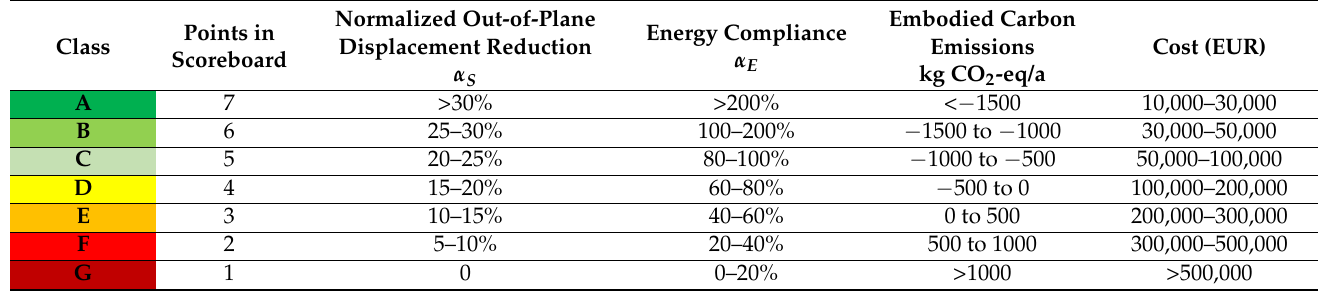
Table 5. Seismic and Energy Retrofitting Scoreboard (SERS): rating